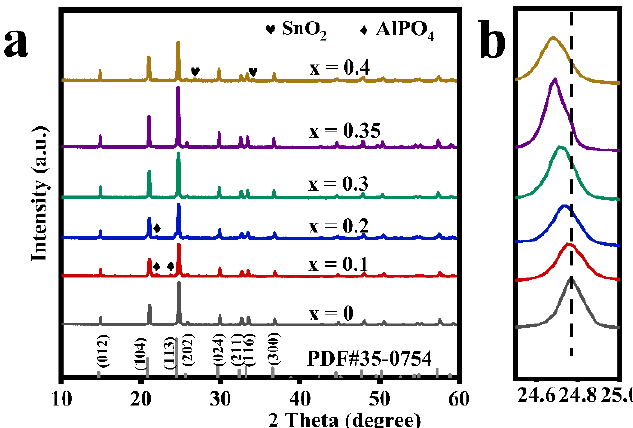
Figure 1. ( a ) X-ray diffraction patterns of LATP-xSn (x = 0–0.4) solid electrolytes and ( b ) the magnified view of diffraction patterns at (113) plane for LATP-xSn (x = 0–0.4) solid electrolytes.